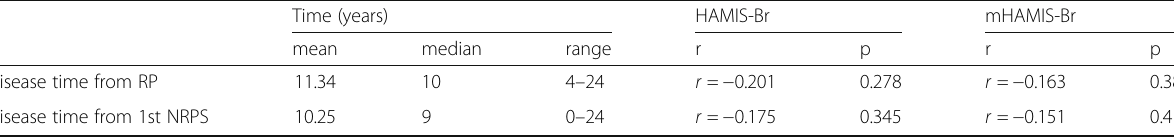
Table 5 Correlation between disease duration and HAMIS-Br and mHAMIS-Br Time